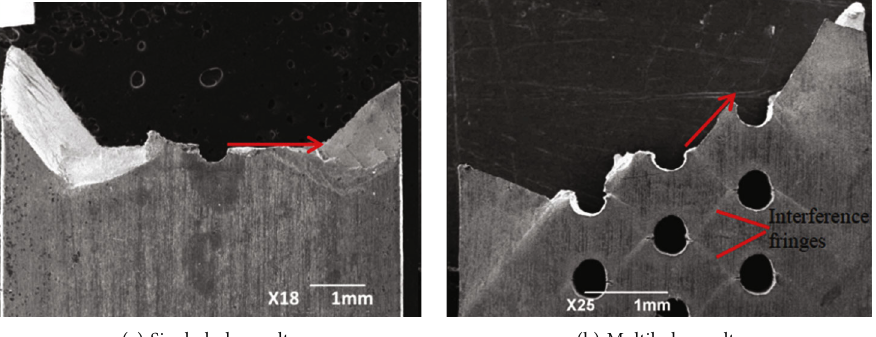
Figure 13: Tested dangerous path